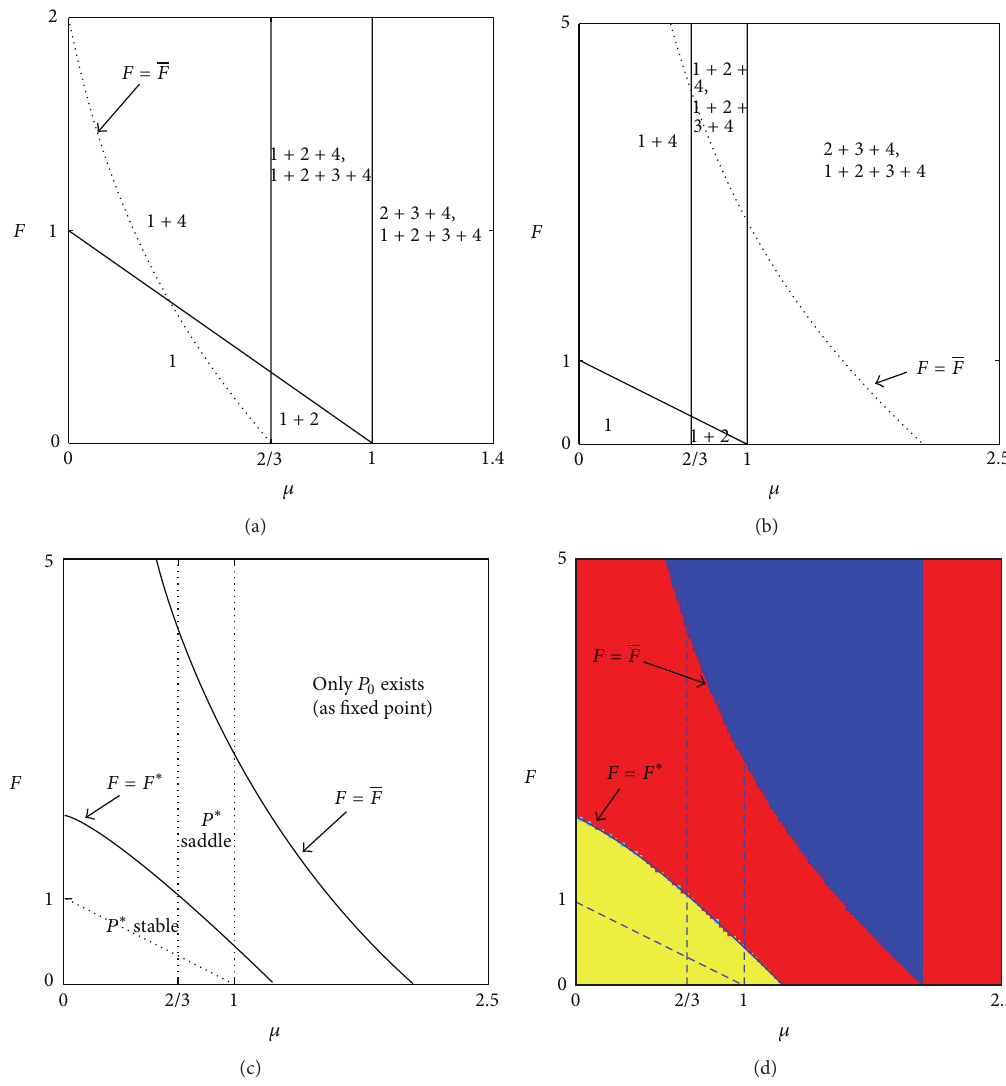
Figure 2: Regions in the parameter plane (𝜇,𝐹) related to the different regimes involved in the definition of system 𝑇 for 𝛼 = 20 and 𝛽 = 60 . In (a) 𝛿 = 2 while in (b) 𝛿 = 14.6 . The black curves separate regions in which 𝑇 is defined by 𝑈 1 (1), 𝑈 1 and 𝑈 2 (1 + 2), 𝑈 1 and 𝑈 4 (1 + 4), and so on. (c) Given the parameters as in (b), the bifurcation curves 𝐹 = 𝐹 ∗ and 𝐹 = 𝐹 are depicted: they represent parameter values such that 𝑃 ∗ loses its stability or the two fixed points merge, respectively. (d) For case (b) the regions denote different asymptotic dynamics for a given initial condition: in red is the 2-period cycle , in blue is the convergence to 𝑃 0 , and in yellow is the convergence to 𝑃 ∗ .